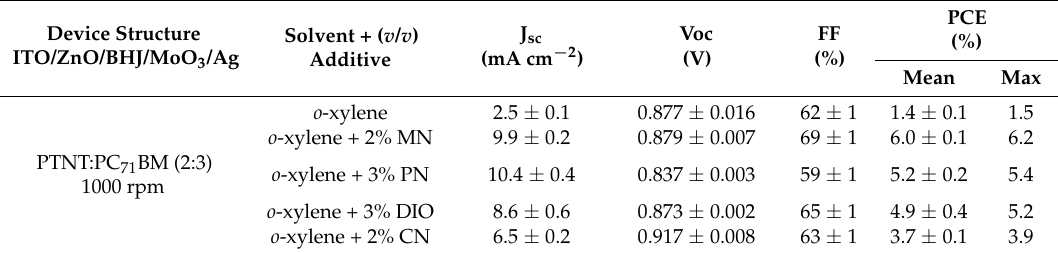
Table 3. Summary of the photovoltaic performance properties of optimized PTNT:PC 71 BM (2:3) solar cells with mean values and standard deviations from six devices.